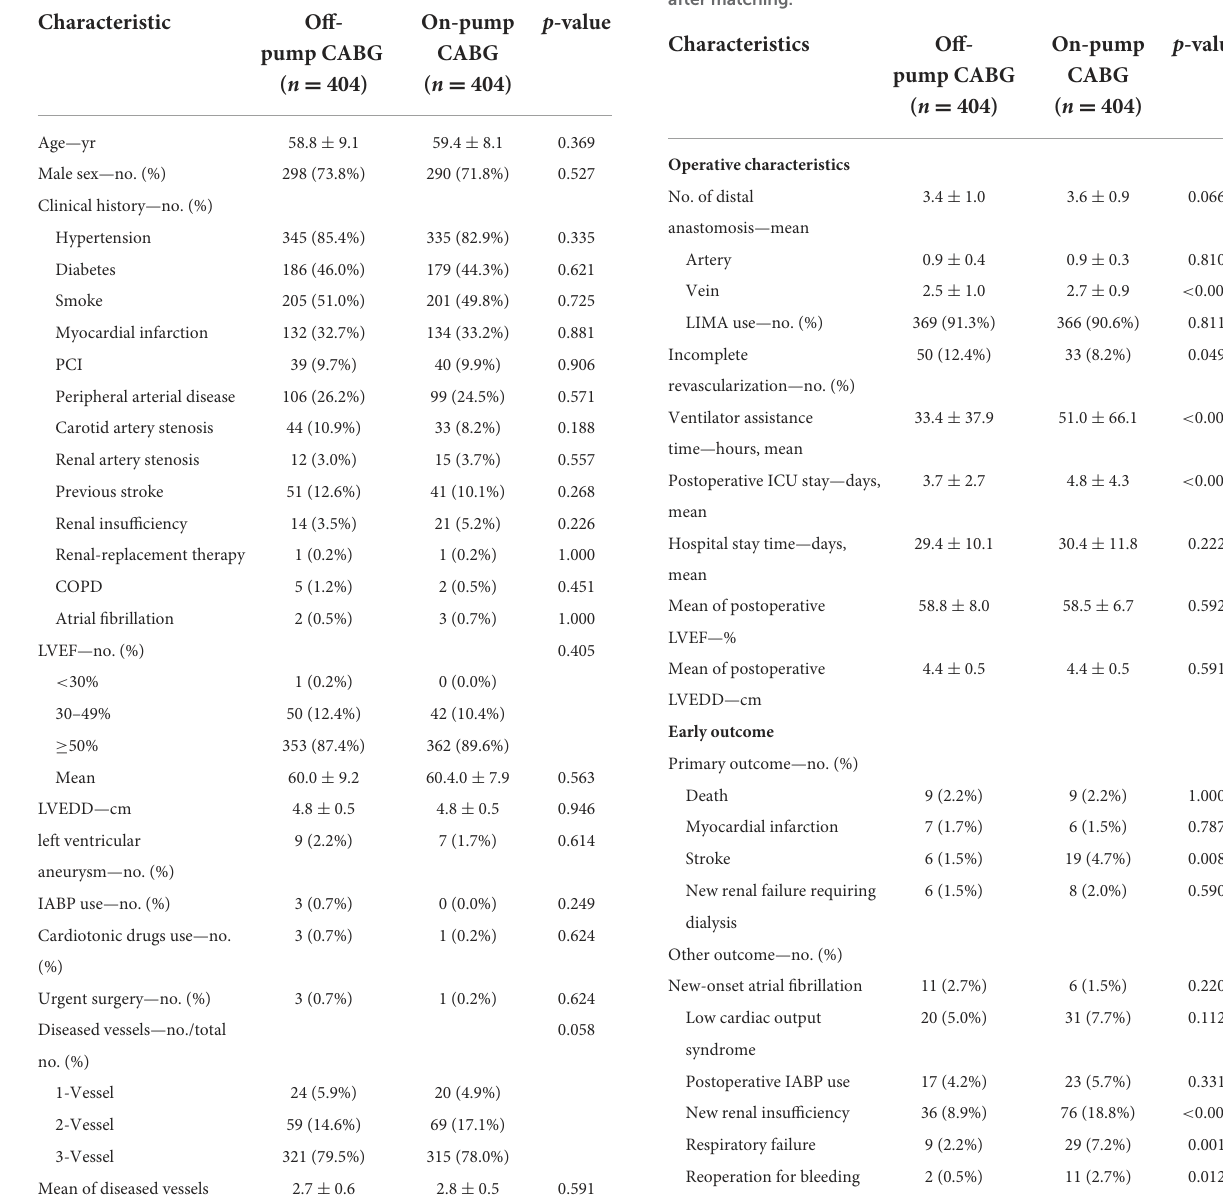
TABLE 3 Baseline characteristics of the patients after matching.